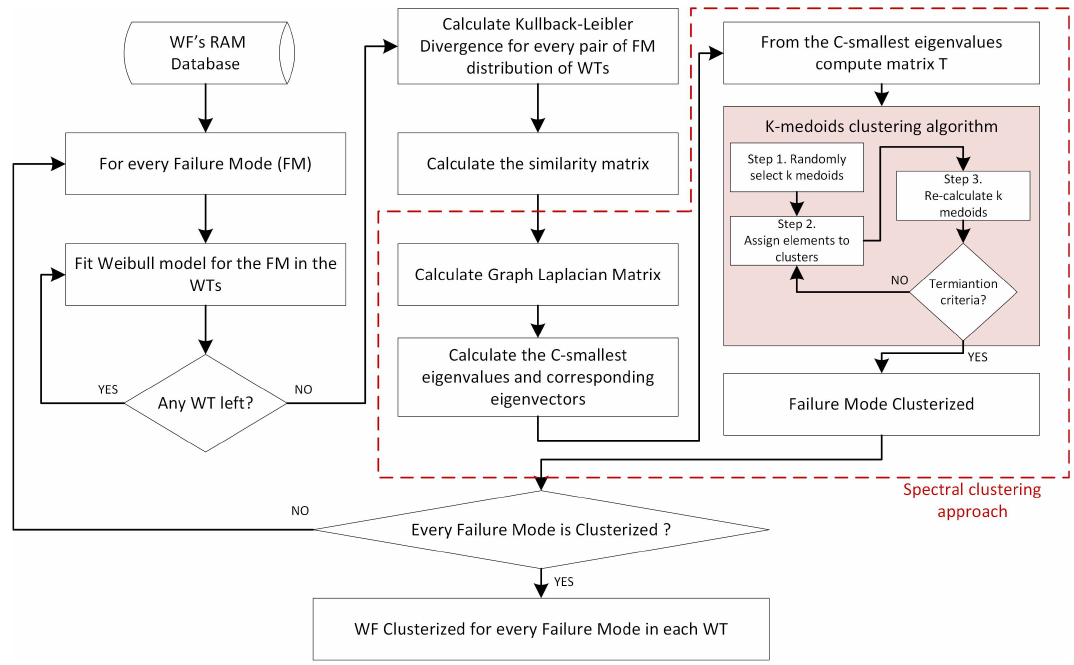
Figure 2. Methodological process of the Reliability Modeling functional